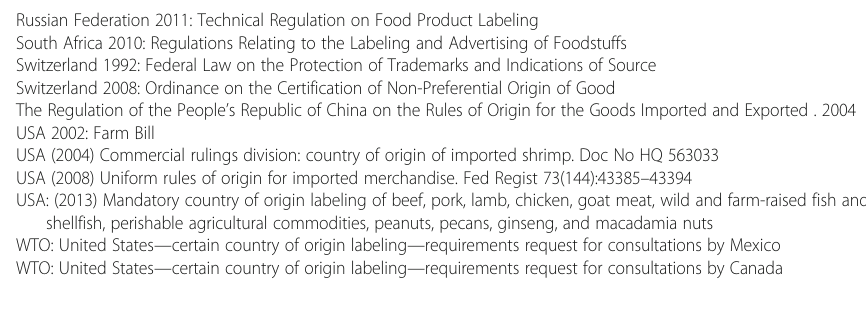
Russian Federation 2011: Technical Regulation on Food Product Labeling South Africa 2010: Regulations Relating to the Labeling and Advertising of Foodstuffs Switzerland 1992: Federal Law on the Protection of Trademarks and Indications of Source Switzerland 2008: Ordinance on the Certification of Non-Preferential Origin of Good The Regulation of the People ’ s Republic of China on the Rules of Origin for the Goods Imported and Exported . 2004 USA 2002: Farm